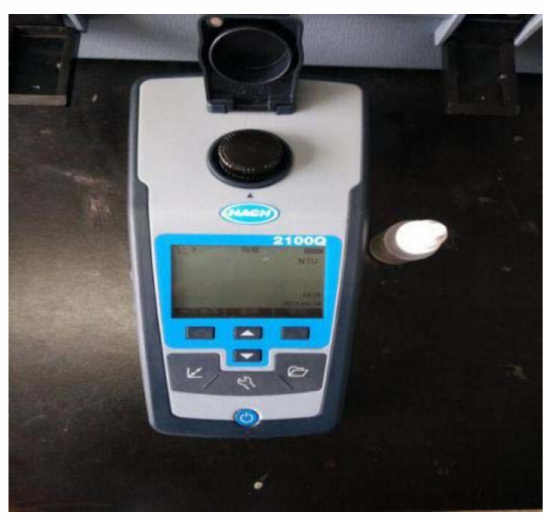
Figure 12. US AHCH2100Q portable turbid